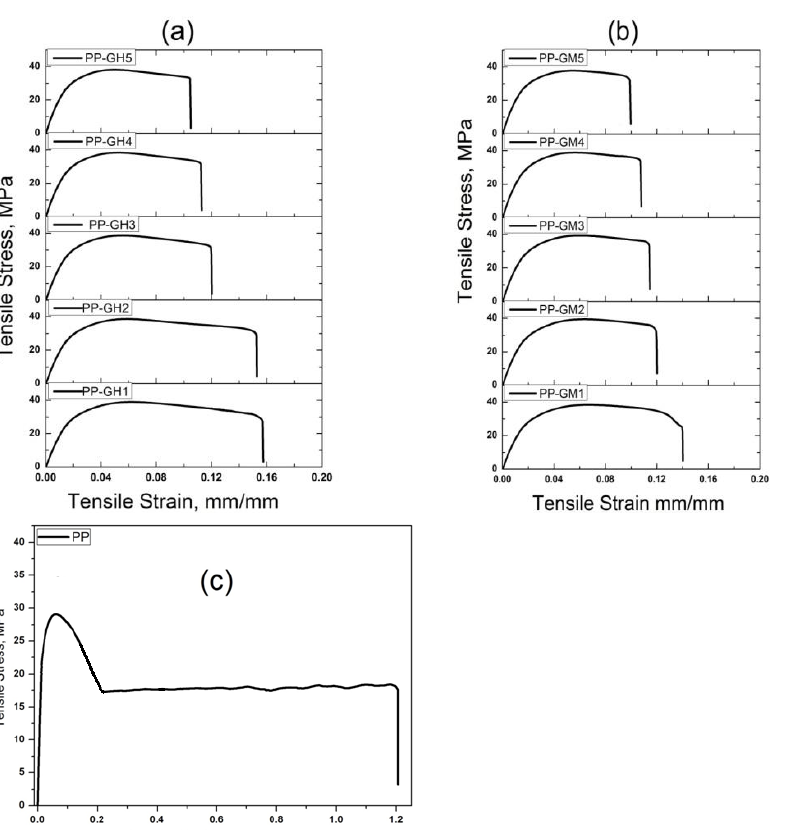
Figure 3. Tensile stress–strain diagrams of ( a ) PP-GH and ( b ) PP-GM composites as a function of increasing amount of GNPs; ( c ) Virgin PP.